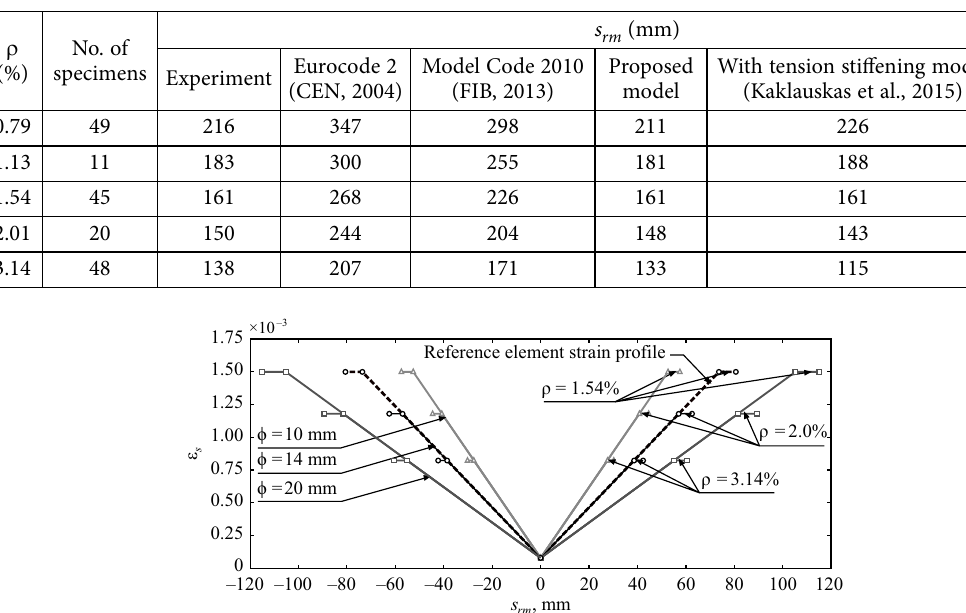
Table 1. Comparison of crack spacing values